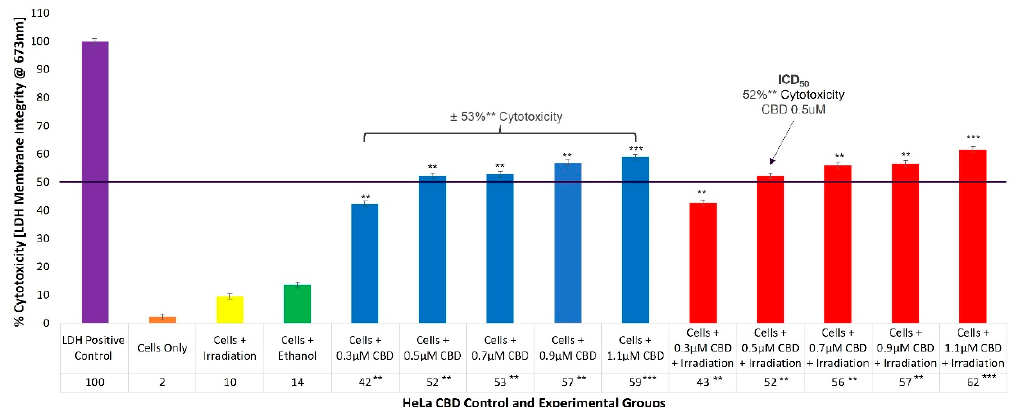
Figure 2. LDH integrity response of HeLa cells treated with varying increasing concentrations of CBD, demonstrating a significant dose-dependent increase in cellular cytotoxicity pre- and post-irradiation ( p < 0.01** or p < 0.001***).